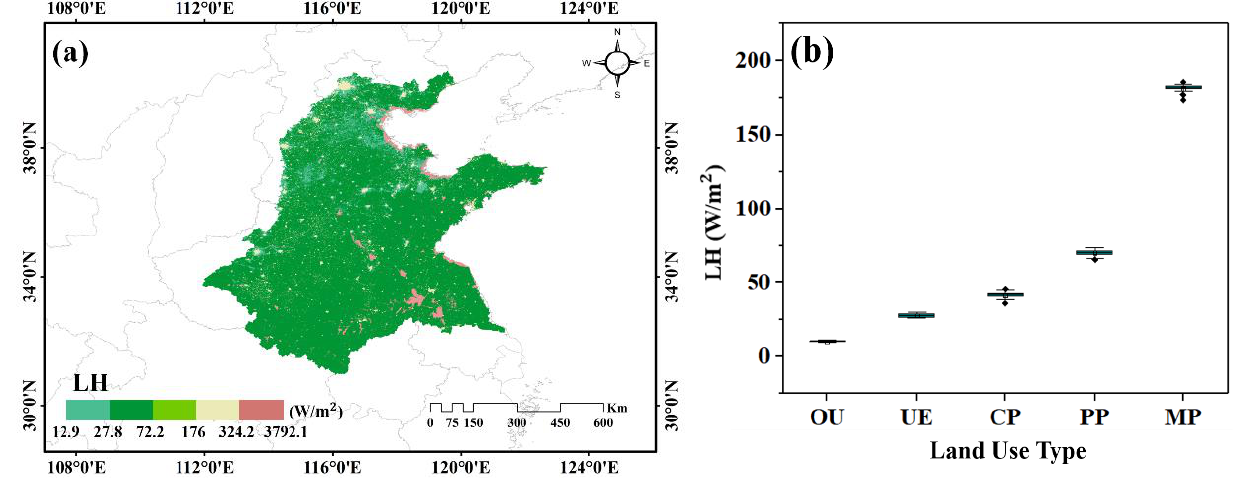
Figure 9. ( a ) Spatial variation of latent heat flux (LH) and ( b ) statistical values for the five land use types in the Huang-Huai-Hai River Basin from 2000 to 2015.